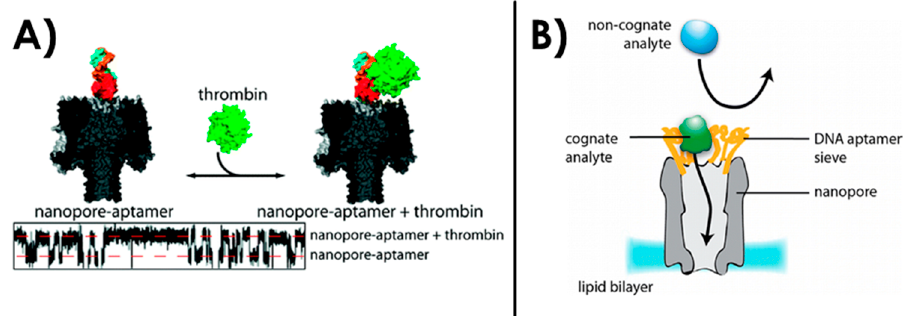
Figure 8. ( A ) α -HL biological nanopore engineered to specifically detect thrombin with a thrombin aptamer at its entrance. Reprinted adapted with permission from [198]. Copyright 2012 American Chemical Society. ( B ) Engineered ClyA nanopore with an aptamer sieve for the specific detection of proteins. Reprinted adapted with permission from [199]. Copyright 2012 American Chemical Society.